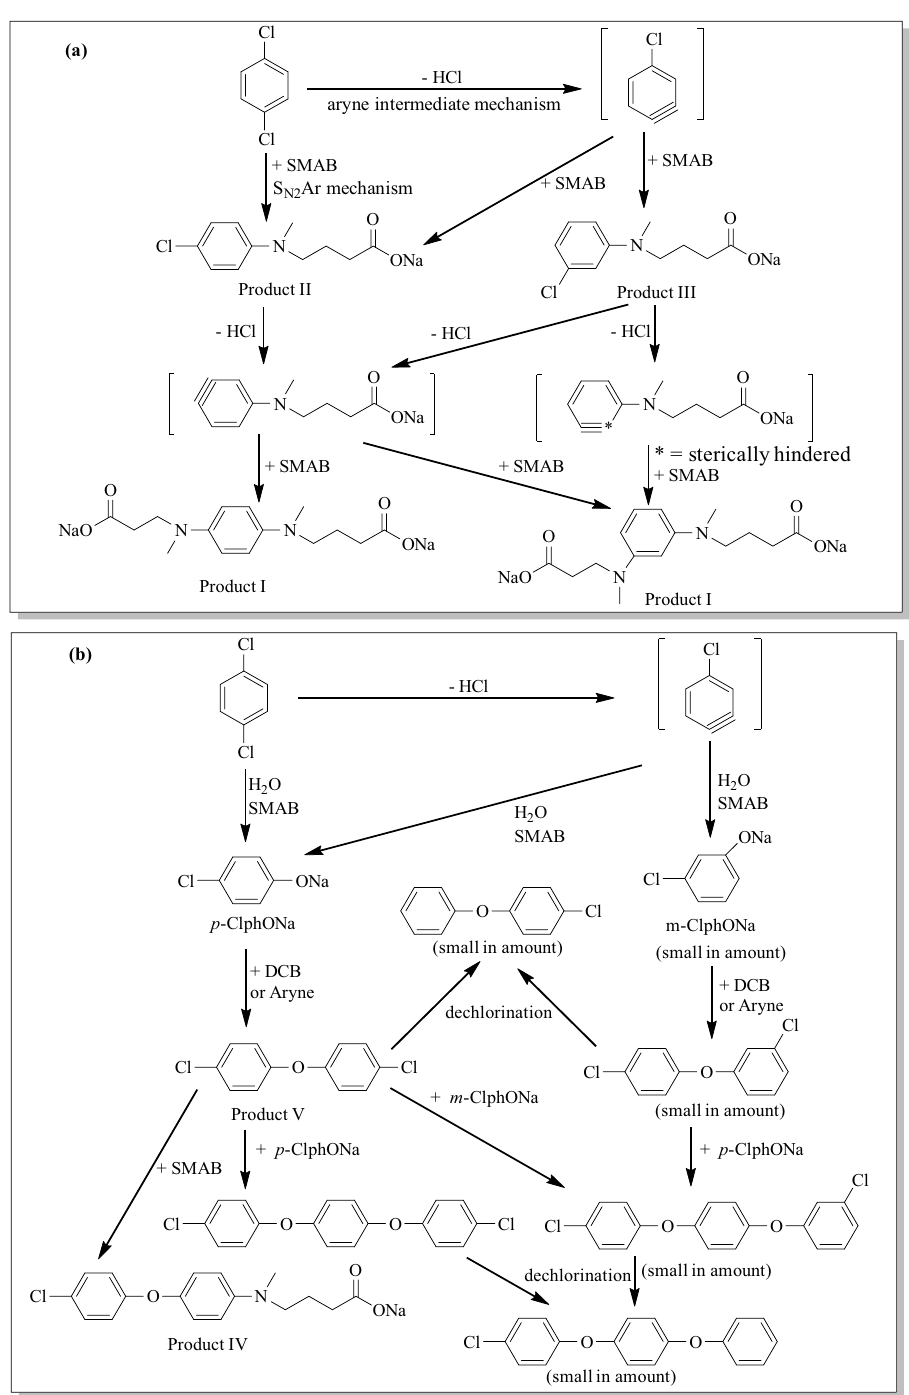
Figure 4: The networks of reactions related to ( a ) the substitution reaction and ( b ) the hydrolysis reaction of